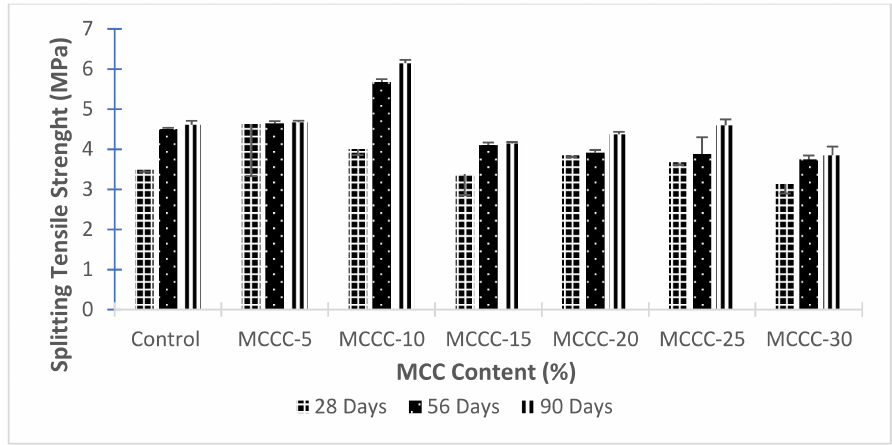
Figure 11. Splitting tensile strength results of HPCs at different treatments with